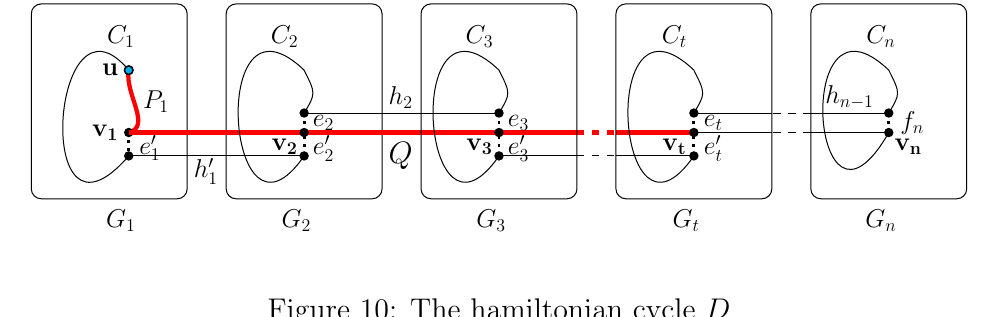
Figure 10: The hamiltonian cycle